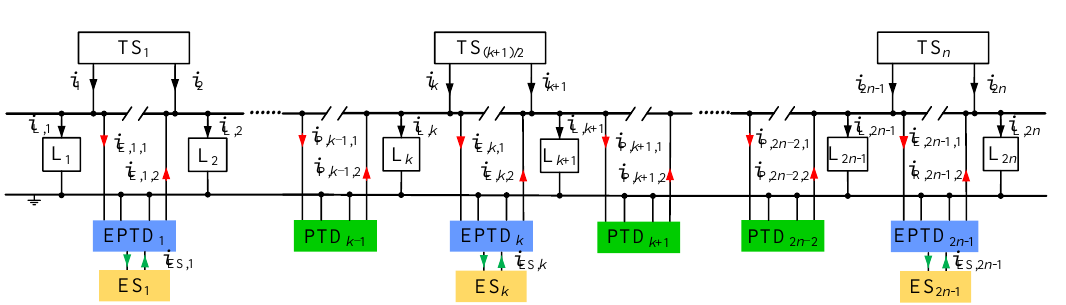
Figure 4. The simplified system and its electrical description.